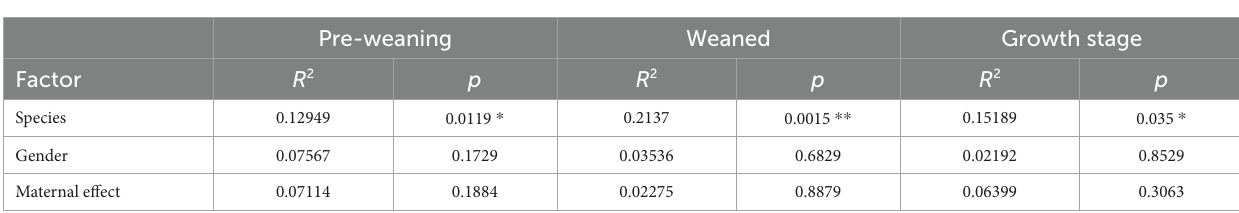
TABLE 1 Andonis results of the microbiome.